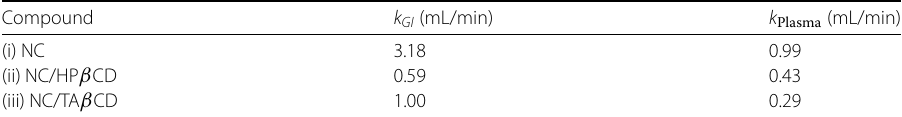
Table 2 Model parameter values in Model B (see [21]) Compound